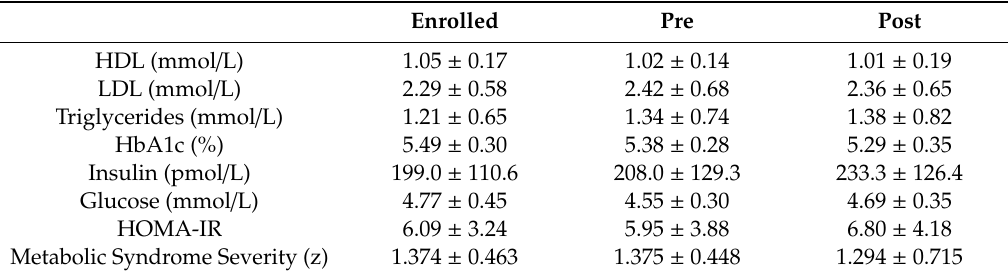
Figure 2. Individual results.